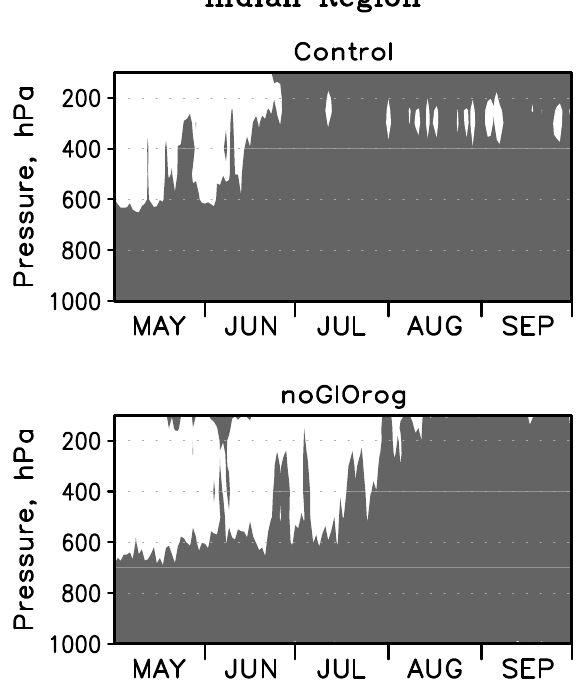
Fig. 20. Vertical Velocity over Indian region in control and noGlO- rog